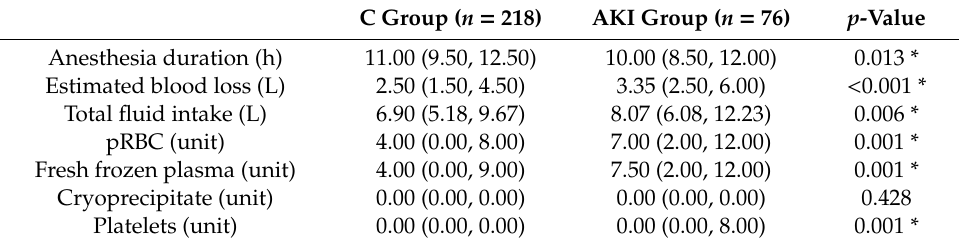
Table 3. Perioperative factors of patients undergoing liver transplantation.